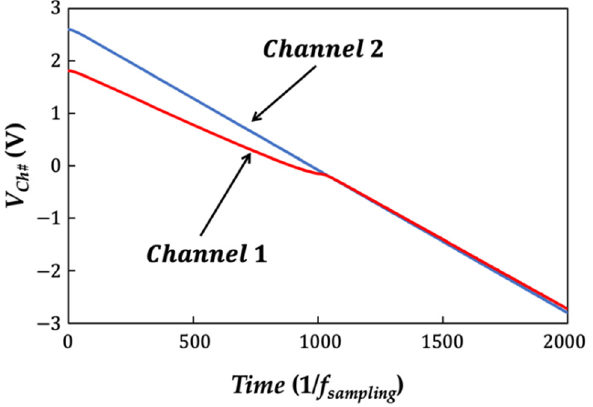
Figure 9. Data measured simultaneously by channels Ch 1 and Ch 2 of the A/DCC to obtain the IVCP. The time axis ranges from 0 to 4 ms.